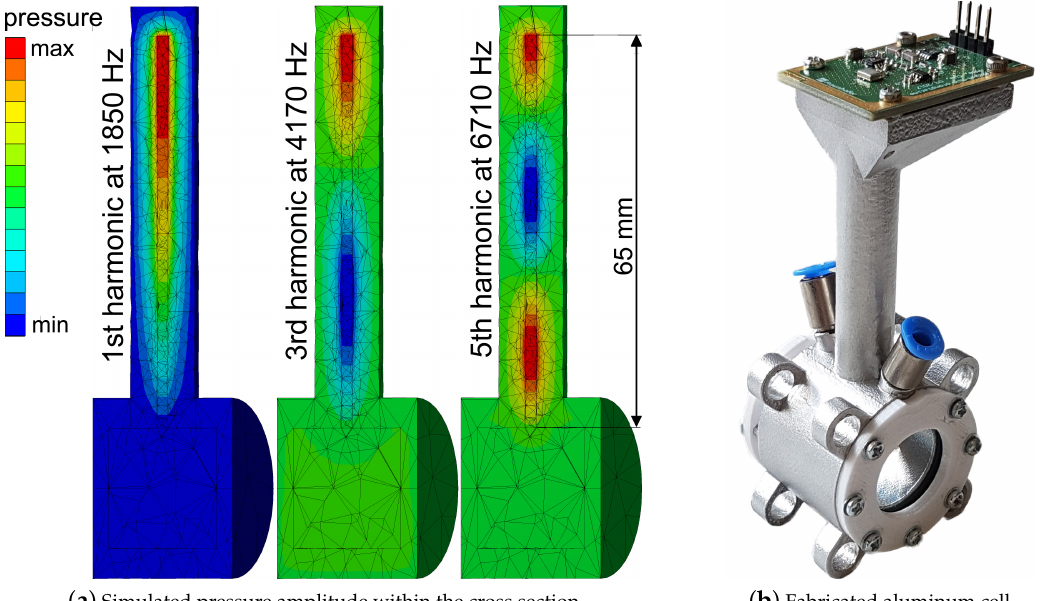
Figure 3. ( a ) Cross section of the cell with simulated pressure amplitude corresponding to standing wave patterns of different harmonics. One can observe the first harmonic at 1850 Hz, the third harmonic at 4170 Hz and the fifth at 6710 Hz. Pressure peaks (red) are at the spot, where the microphone will be assembled. As expected, no standing wave pattern is formed within the absorption chamber. ( b ) Picture of the aluminum cell with mounted microphone and windows (100 mm × 40 mm × 40